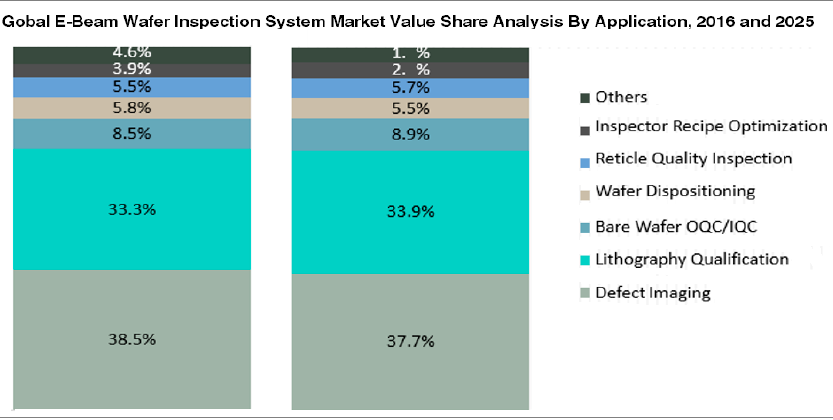
Figure 30. Global E-beam wafer inspection system market value share analysis by application, 2016–2025.